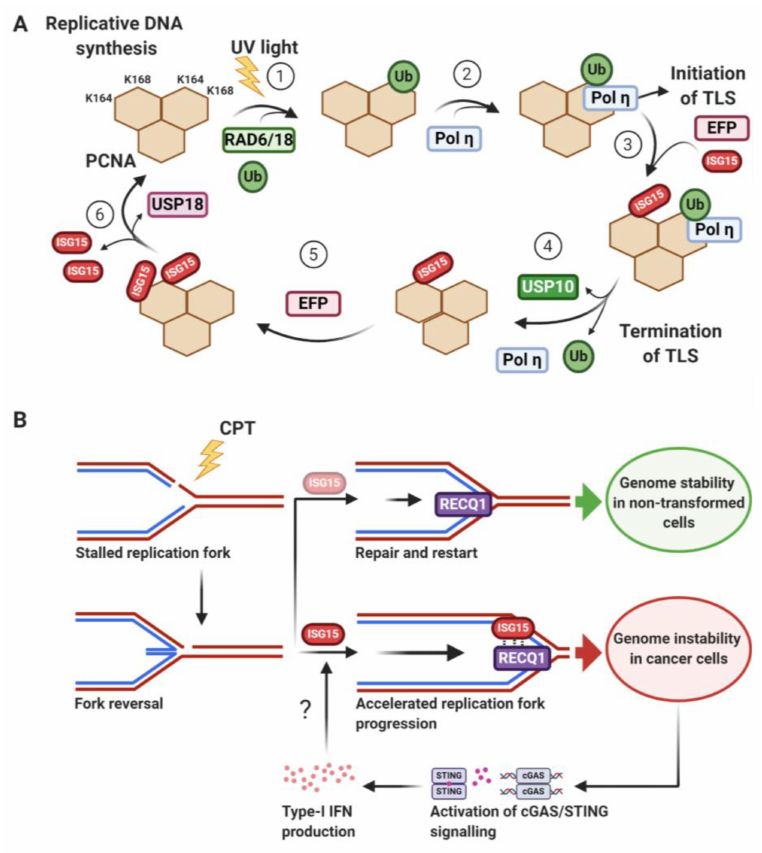
Figure 6. ISG15 in DNA synthesis—replicating past lesions. ( A ) Termination of translesion DNA synthesis (TLS) by ISGylation of PCNA. Under non-stressed conditions, PCNA serves as a processivity factor for replicative DNA synthesis. In response to certain types of DNA damage (e.g., UV light) PCNA is key to initiating and terminating TLS as follows: (1) PCNA is monoubiquitylated by the RAD6 / RAD18 E3 ligase complex at K164 in one of its three identical subunits, which (2) recruits the translesion polymerase Pol η to carry out TLS. (3) After bypass of the lesion, EFP ISGylates PCNA at lysine K168. (4) ISGylation of PCNA triggers recruitment of the deubiquitylase USP10, which in turn deubiquitylates PCNA and releases Pol η to avoid UV-induced mutagenesis. (5) A further ISGylation step of PCNA by EFP at lysine K164 likely prevents additional cycles of monoubiquitylation. (6) Finally, USP18 (aka UBP43) deISGylates PCNA and allows reloading of replicative DNA polymerases as well as resumption of replicative cell replication. ( B ) ISG15 accelerates replication fork progression. Association of ISG15 with the DNA helicase RECQ1 accelerates replication and promotes stalled replication fork restart. While multiple mechanisms of replication fork restart and reversal exist, single-stranded DNA (ssDNA) is typically exposed to and bound by RPA, which triggers events leading to DNA loading of PCNA and its polyubiquitylation by UBE2N (aka UBC13). Upon fork reversal complementary nascent DNA strands can be used as a template to bypass DNA lesions, such as those caused by camptothecin (CPT). Reversed forks are stabilised by di ff erent factors before being restarted by RECQ1 although the exact mechanisms behind this are unclear [172]. ISG15 accelerates RECQ1 activity leading to increased rates of DNA synthesis, potentially interfering with coordination of fork restart, thereby promoting genome instability. In cancer cells overexpressing ISG15, this increased genome instability has the potential to create a positive feedback loop mediated by cGAS / STING signalling whereby type-I interferons are upregulated following DNA damage, although the exact underlying mechanisms remain to be determined e.g. in light of recently described e ff ects of cGAS / STING on replication fork progression [173]. Ub: Ubiquitin. Figure created using BioRender.com